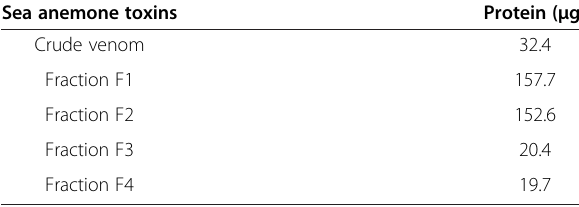
Table 1 Protein quantification of CV and fractions isolated from B. globulifera at 1 mgmL -1 using the Bradford